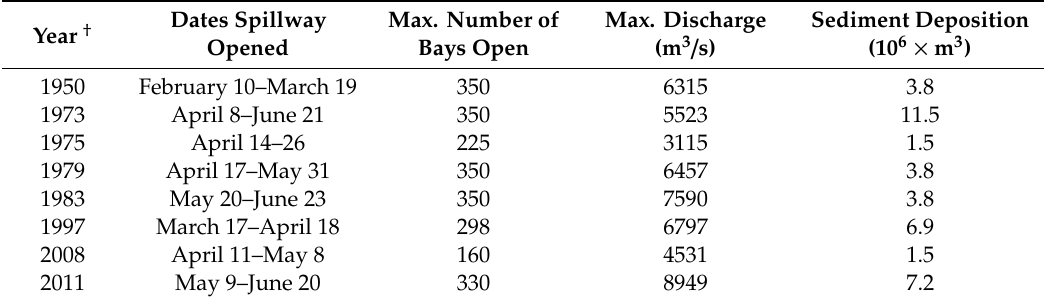
Table 5. Opening dates of the Bonnet Carr é Spillway (BCS) due to di ff erent flood events from 1950 to 2011. This table also includes maximum bays open, maximum water discharge, and estimated sediment deposition (modified from Day et al.